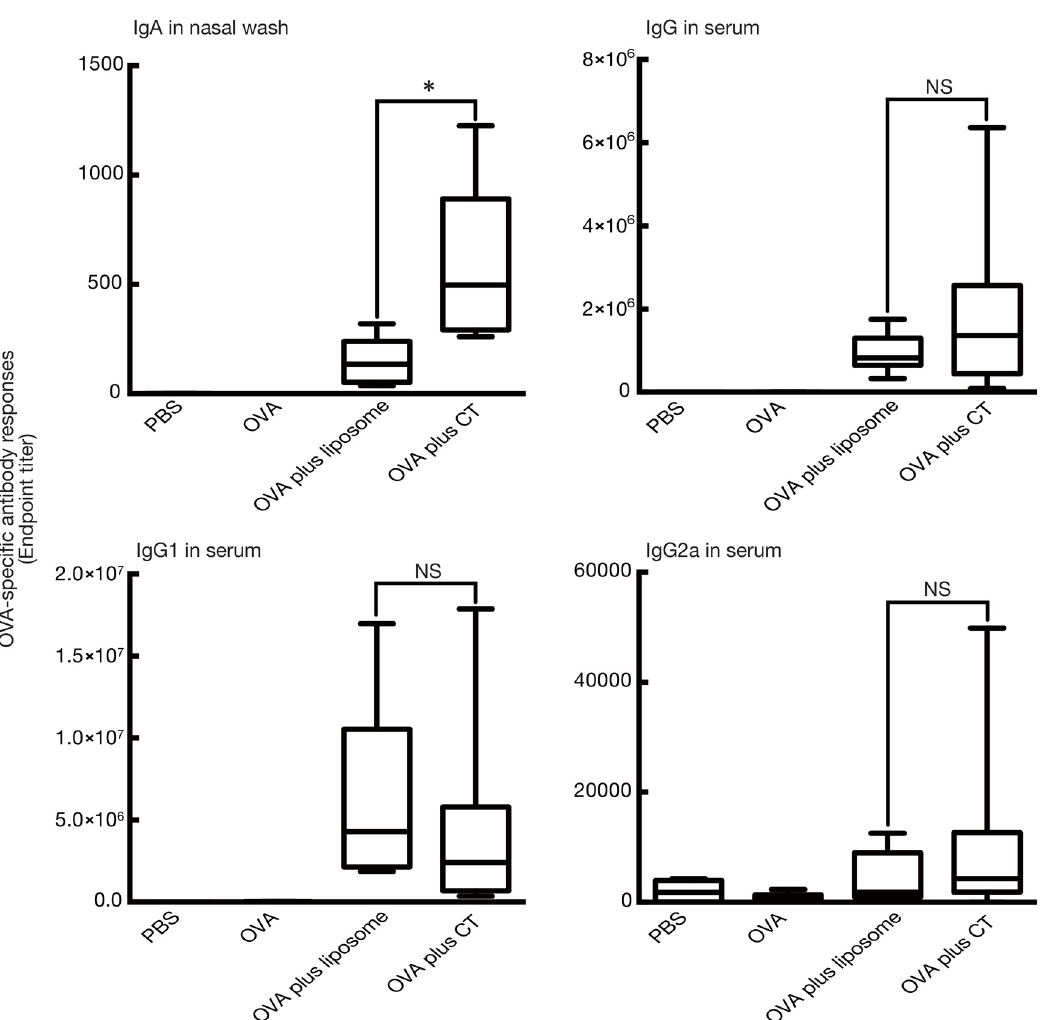
Fig 5. Comparison of the mucosal adjuvant activity of DOTAP/DC-chol liposomes with CT. BALB/c female mice were immunized intranasally with PBS, OVA (5 μ g/mouse) alone, OVA (5 μ g/mouse) plus DOTAP/DC-chol liposomes (0.4 μ mol/mouse), or OVA (5 μ g/mouse) plus CT (1 μ g/mouse) on days 0 and 7. Serum and nasal washes were collected on day 14. The anti-OVA IgG, IgG1, and IgG2a levels in serum and anti-OVA IgA level in nasal washes were detected by ELISA assay as described in the “ Materials and Methods ” section. The data were obtained from at least three independent experiments. The box-plot shows the median value with the 25th-75th percentiles and the error bars indicate the 5th-95th percentiles. Significance was assessed using the Kruskal – Wallis with Dunn ’ s post – hoc test: * p < 0.05, NS: not